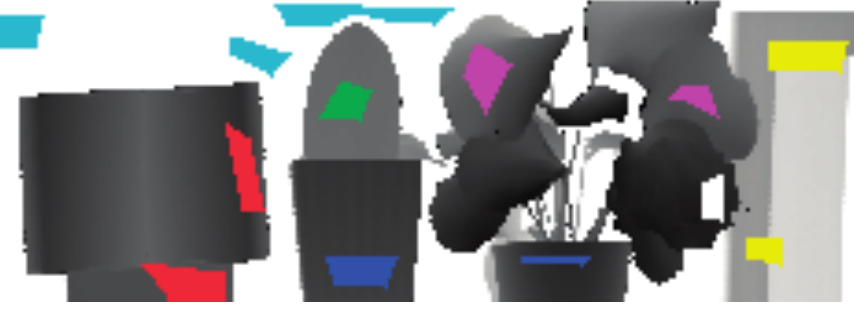
Figure 3. Selection of the training dataset for each prior class with different